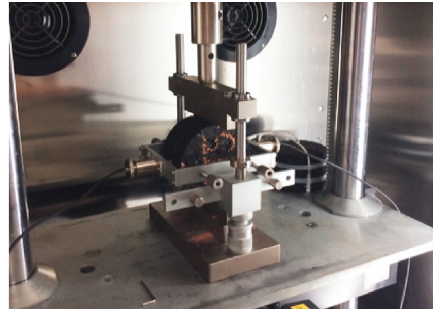
Figure 3: Resilient modulus test of indirect tensile strength.